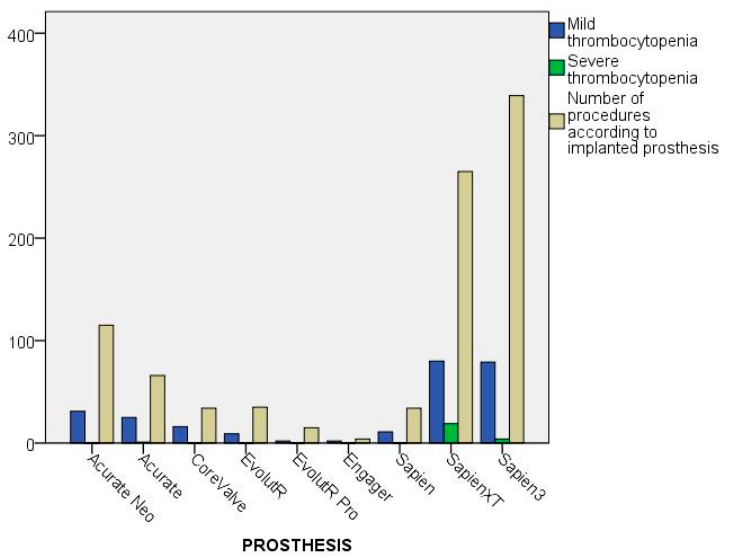
Figure 3. Boxplot showing the evolution of corrected platelet counts sorted by access and postopera- tive days.